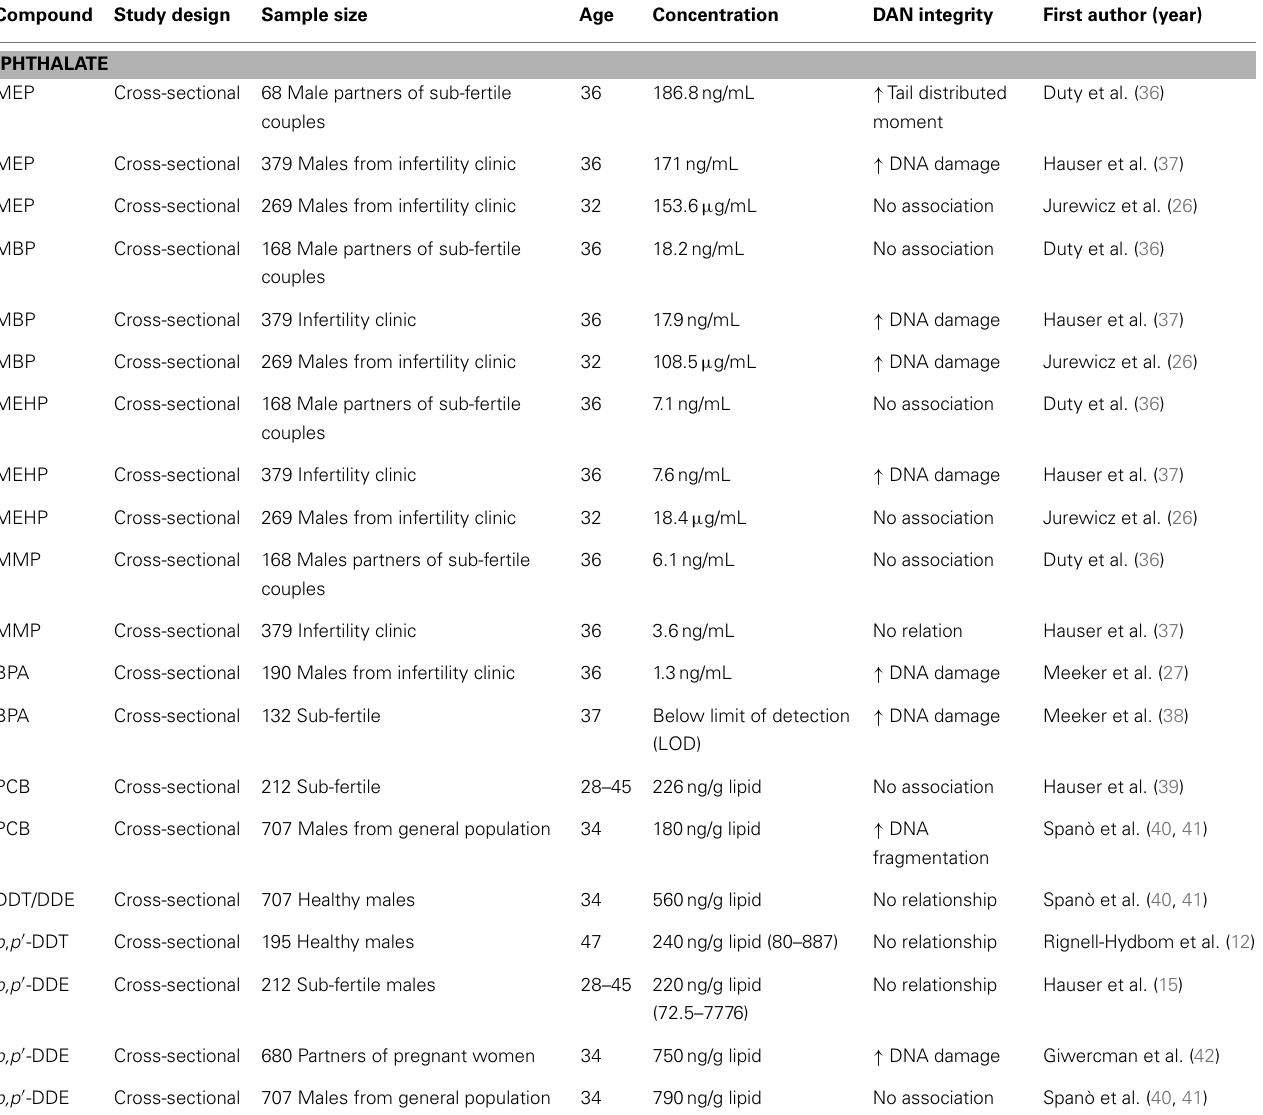
Table 2 | Epidemiological studies on DNA integrity and endocrine disruptors including phthalates, BPA, PCB, and DDT/DDE